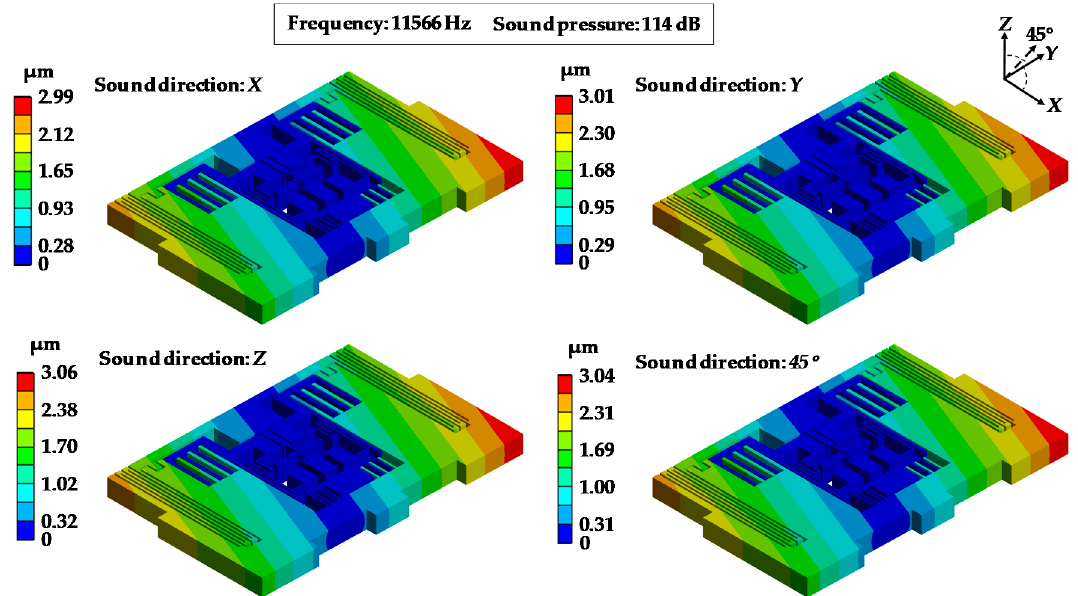
Figure 14. Deformations of MPU6050-Y under acoustic injection in different sound directions.